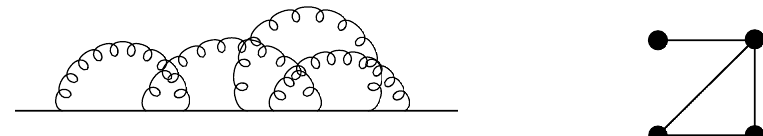
Figure 4. Example of intersection graph associated to a Feynman diagram with four gluons: for each gluon, draw a dot on the plane; each time two gluon lines intersect, draw a link between the corresponding two